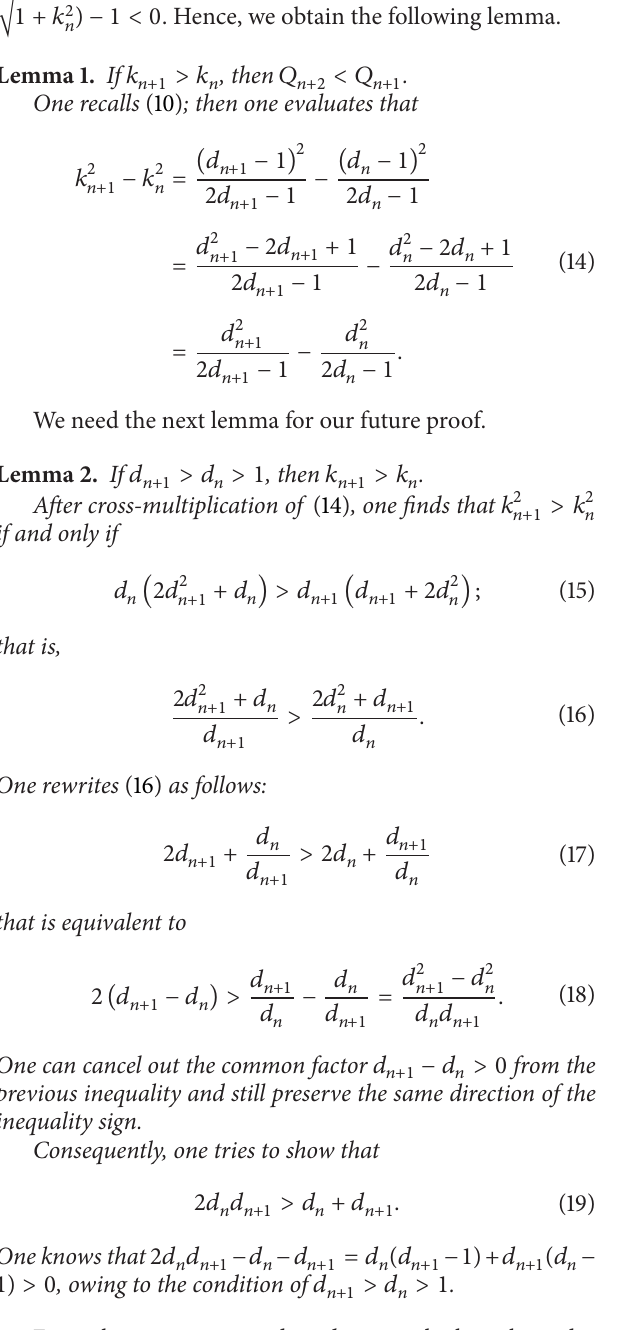
Table 1: For 𝛽 = 0.5 and 𝐿 3 = 3 , the convergence of proposed three